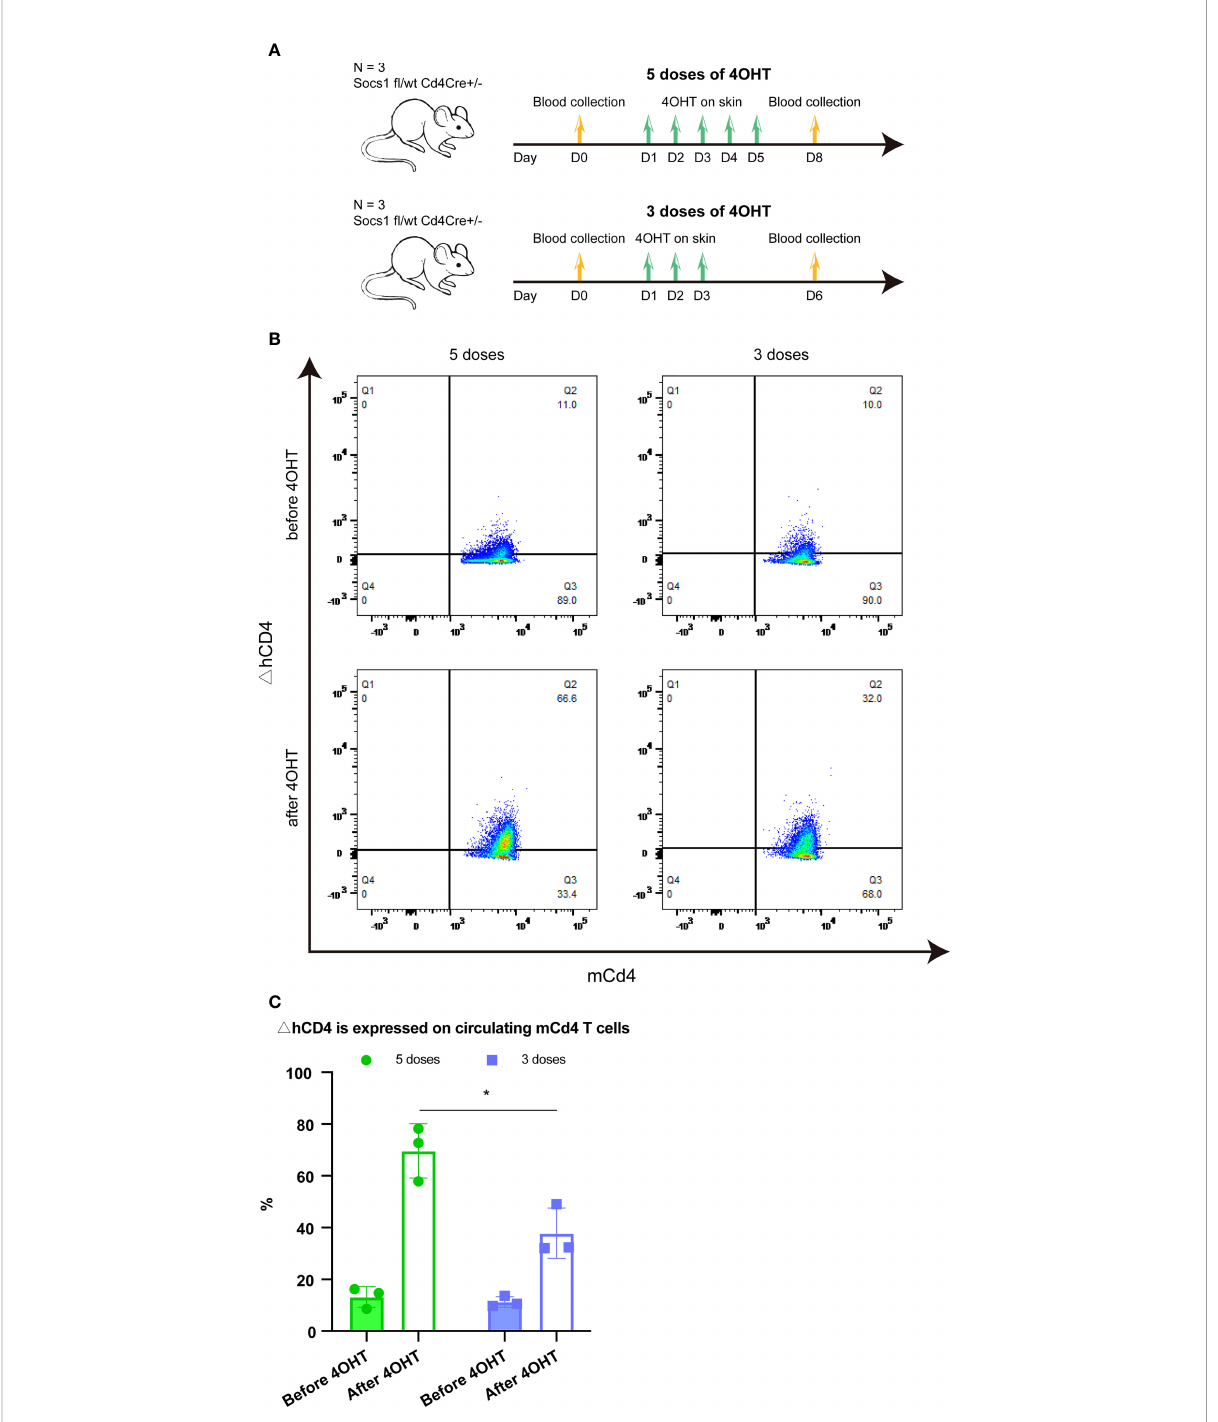
FIGURE 2 Effect of fi ve and three times 4OHT application on the skin (A) . Schematic representation of the experiment determining the effect of 5 and 3 doses of 4OHT. Blood (50 m l) was drawn from the tail veil before 4OHT application and 3 days after the last 4OHT application and subjected to FACS analysis. (B) . Reporter D hCD4 expression in circulating mCd4 T cells using FACS analysis. Representative fl ow plots of blood obtained before 5 doses of 4OHT, after 5 doses of 4OHT, before 3 doses of 4OHT, and after 3 doses of 4OHT. (C) . Cells with Socs1 deletion (resulting in D hCD4 expression) in percentage of total circulating murine CD4 T cells in transgenic Socs1 fl /wt Cd4Cre+ mice. Data are presented as mean ± SD. Symbols in bar graphs represent individual mouse.